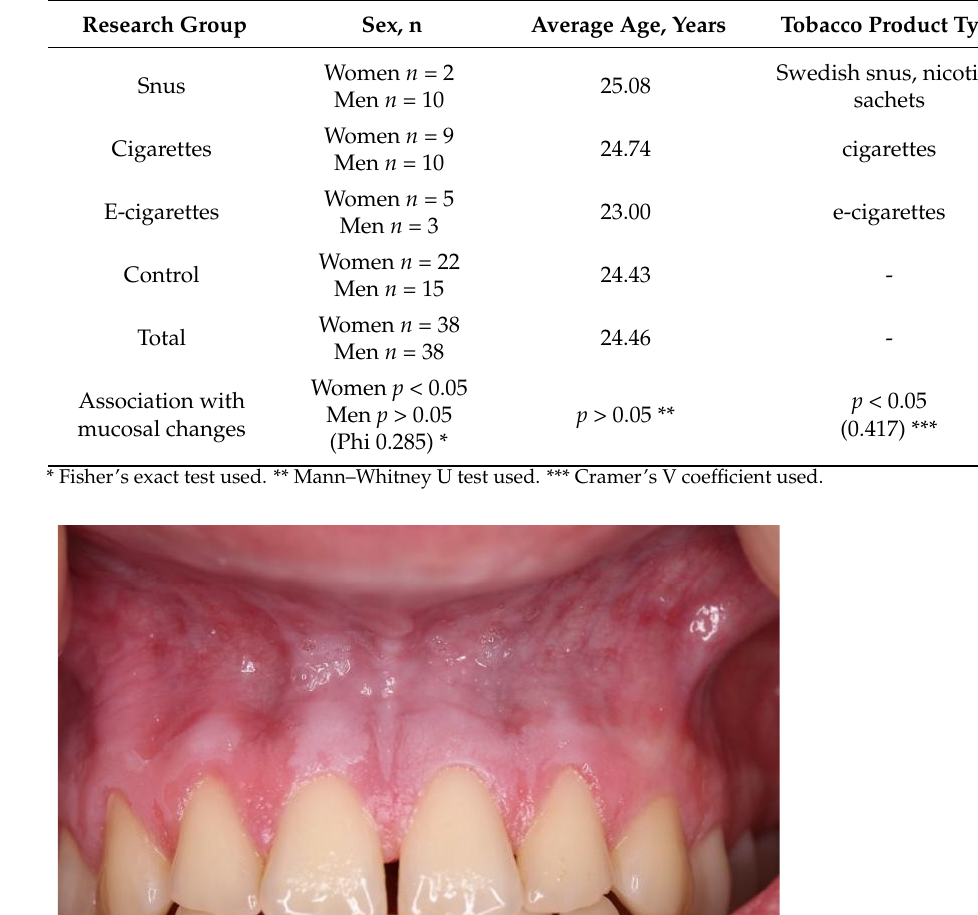
Table 2. Association between mucosal changes and average age, sex, and tobacco product type used.